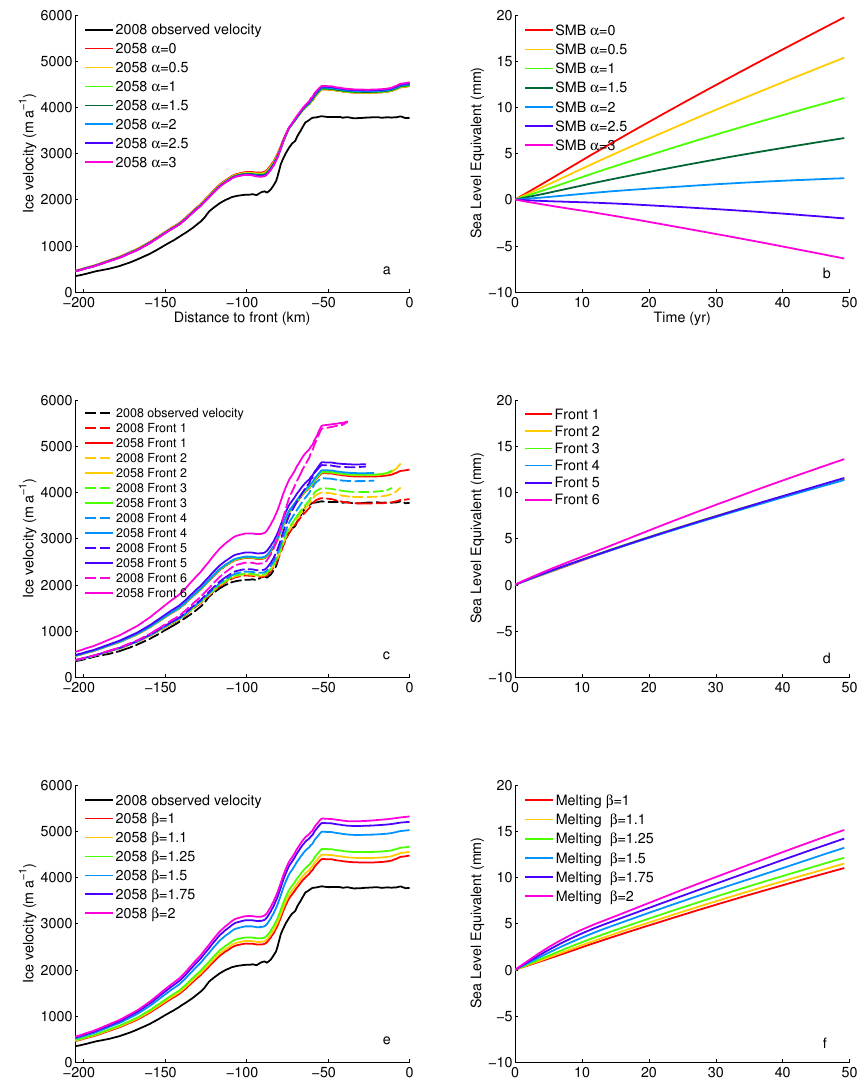
Figure 5. Modeled velocity sensitivity (left column) and volume above floatation sensitivity (right column) to (a, b) surface mass balance; (c, d) ice front position and (e, f) ice shelf melting. Solid lines in the left column represent the ice velocity at the end of the simulation and dashed line the initial velocity after ice front retreat when ice front position is changed.